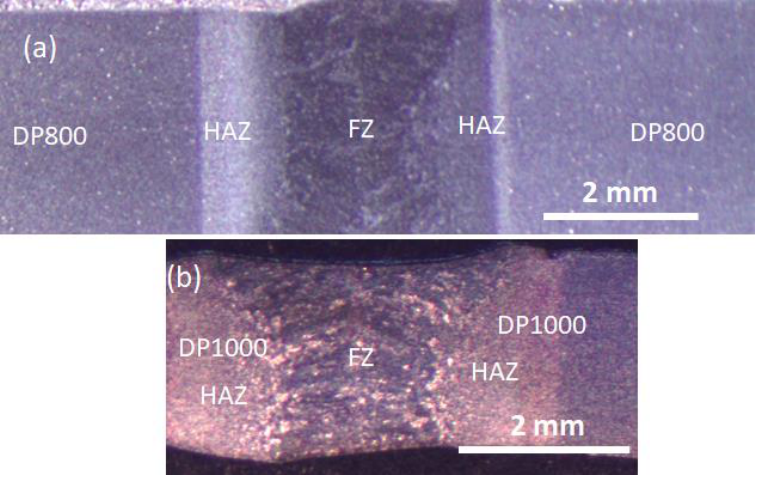
Figure 2. ( a , b ) light optical micrographs of the cross-sections of the DP800-DP800 and DP1000-DP100 welded joints.